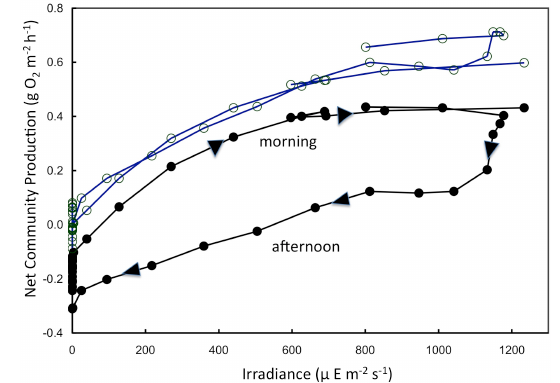
Fig. 5. Changes in hourly net community (benthic + pelagic) pro- duction (full circles) and gross production (open circles), calculated as net community production minus temperature-corrected respira- tion rates in Mari L´opez Lagoon as a function of irradiance along the course of the day (i.e., the direction of the arrow in the full cir-